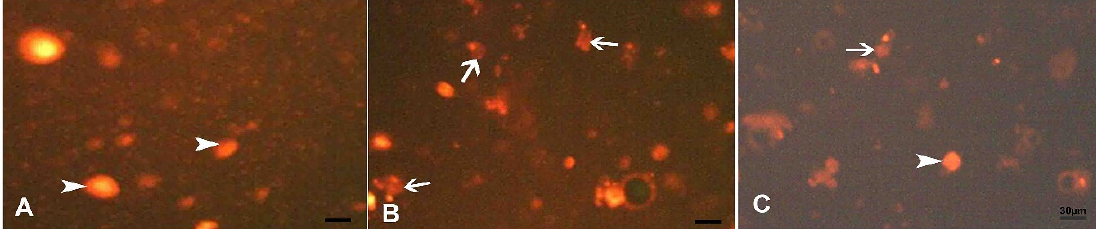
Figure 6. Comet assay of acinar cells of the parotid of adult male albino rats of study groups. ( A ) Control group, normal condensed type nuclei and undamaged cells (arrow head). ( B ) AOH group, abnormal tailed nuclei and damaged cells (arrow). ( C ) AOH + gallic group, some cells with tailed nuclei (arrow) and other are normal (arrow head).